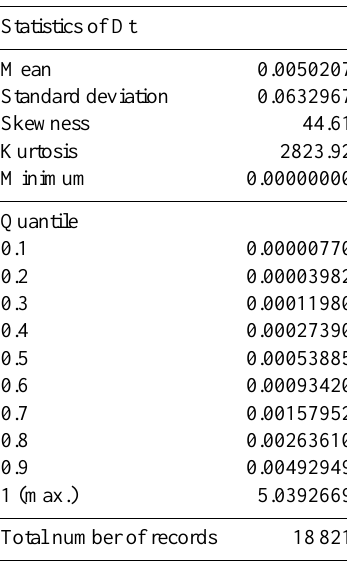
Table 3. Statistics of Dt and Dt 60